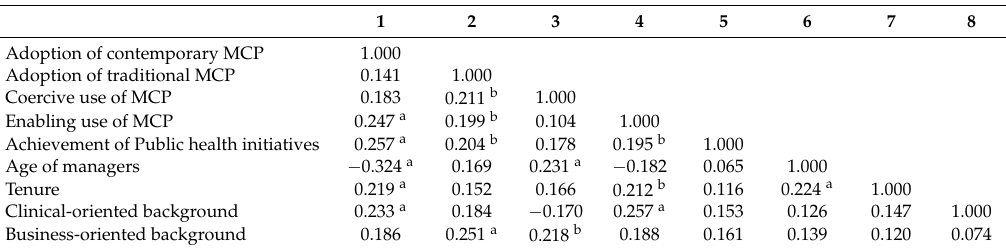
Table 4. Correlations among research variables.